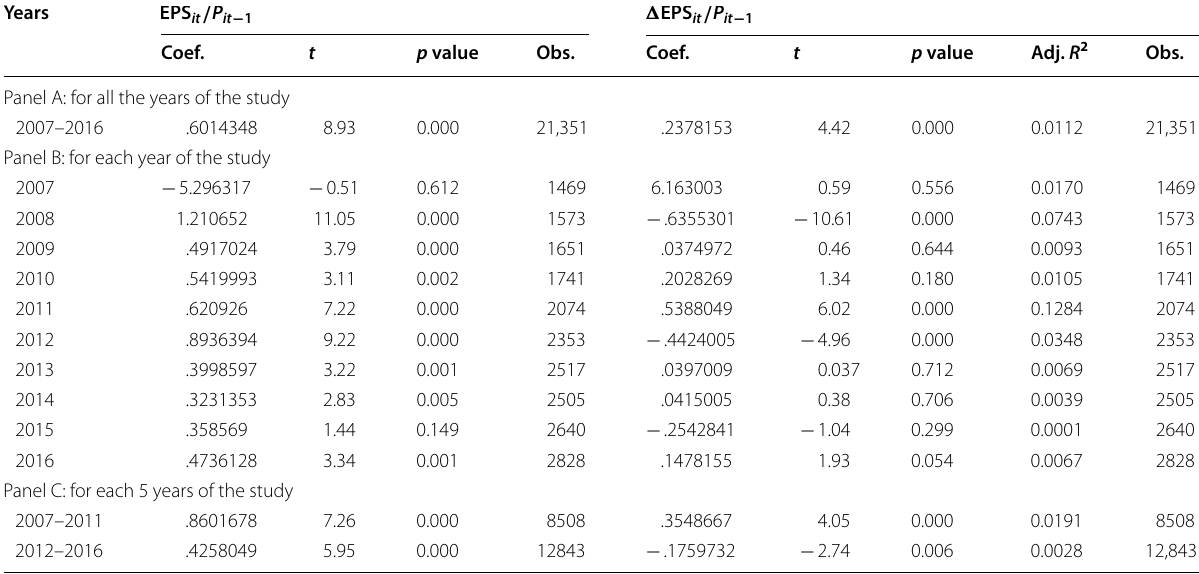
Table 4 Regression results using Model